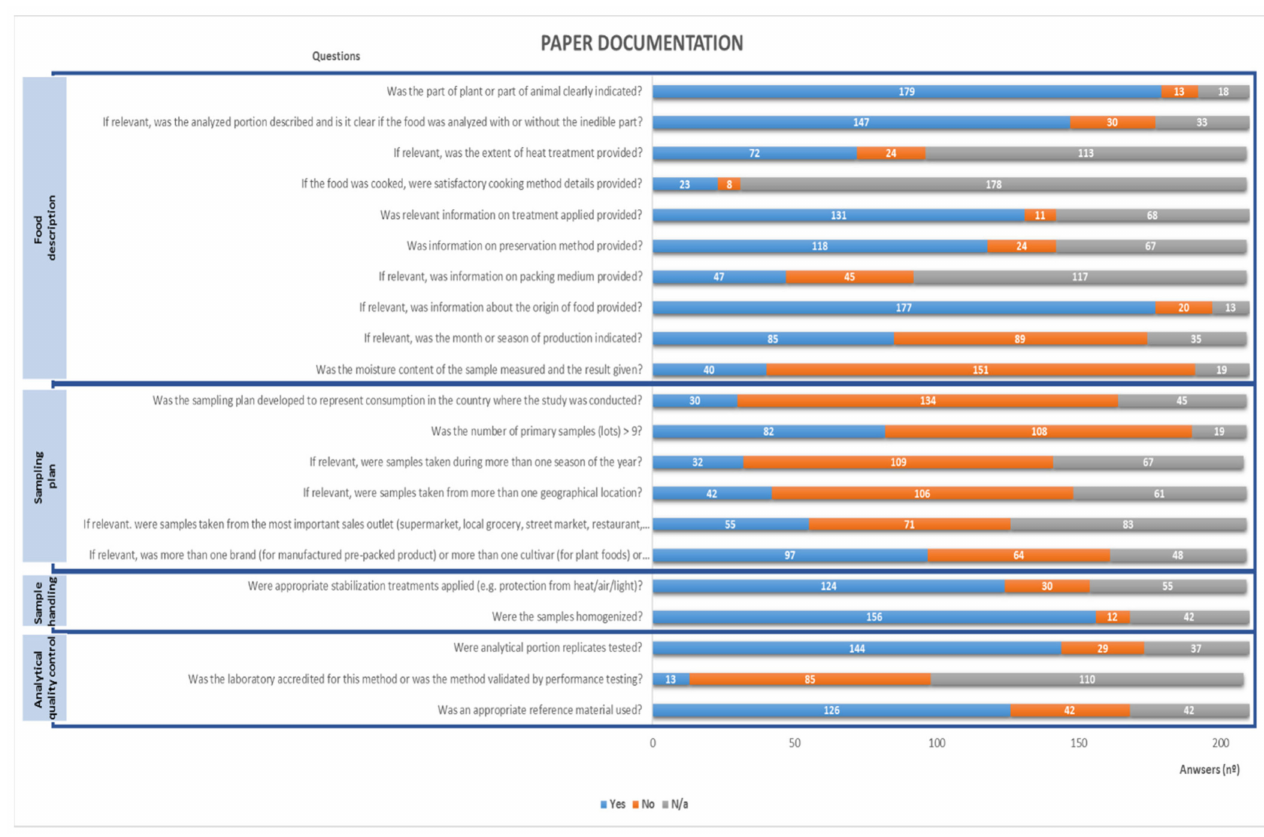
Figure 1. Paper documentation evaluation, for food composition databases, by the EuroFIR